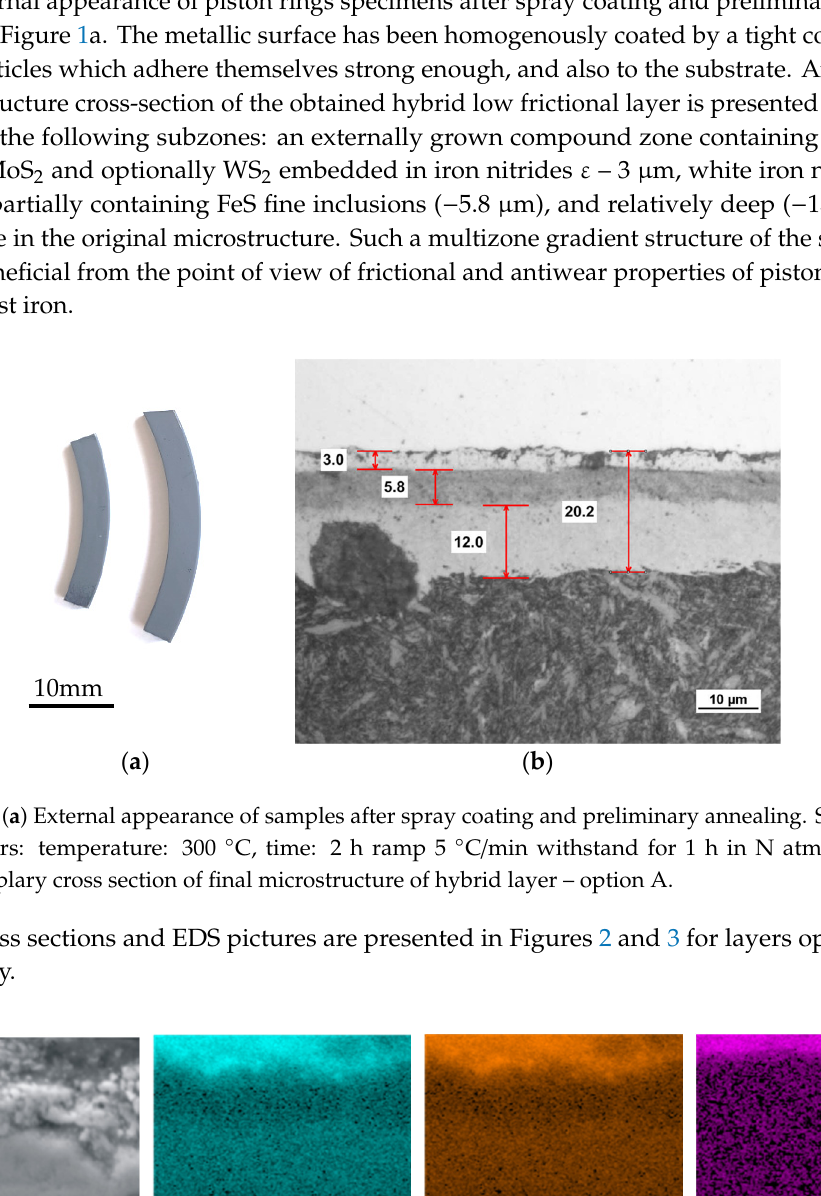
( b ) Figure 4. ( a ) Comparison of friction coefficients obtained during tribological tests; ( b ) Comparison of the maximum depth of frictional tracks. The specimens treated in the hybrid process according to the schedule and parameters of option A have shown an extremely low value of dry friction coefficient, 0.13, which is two-fold than the non- optimum layers, e.g., those treated to the schedule and parameters of option B (Figure 4). Also, the linear wear results after tribological tests have been twice as less for specimens treated according to the parameters A. That low frictional effect is the result of layered microstructure of numerous and